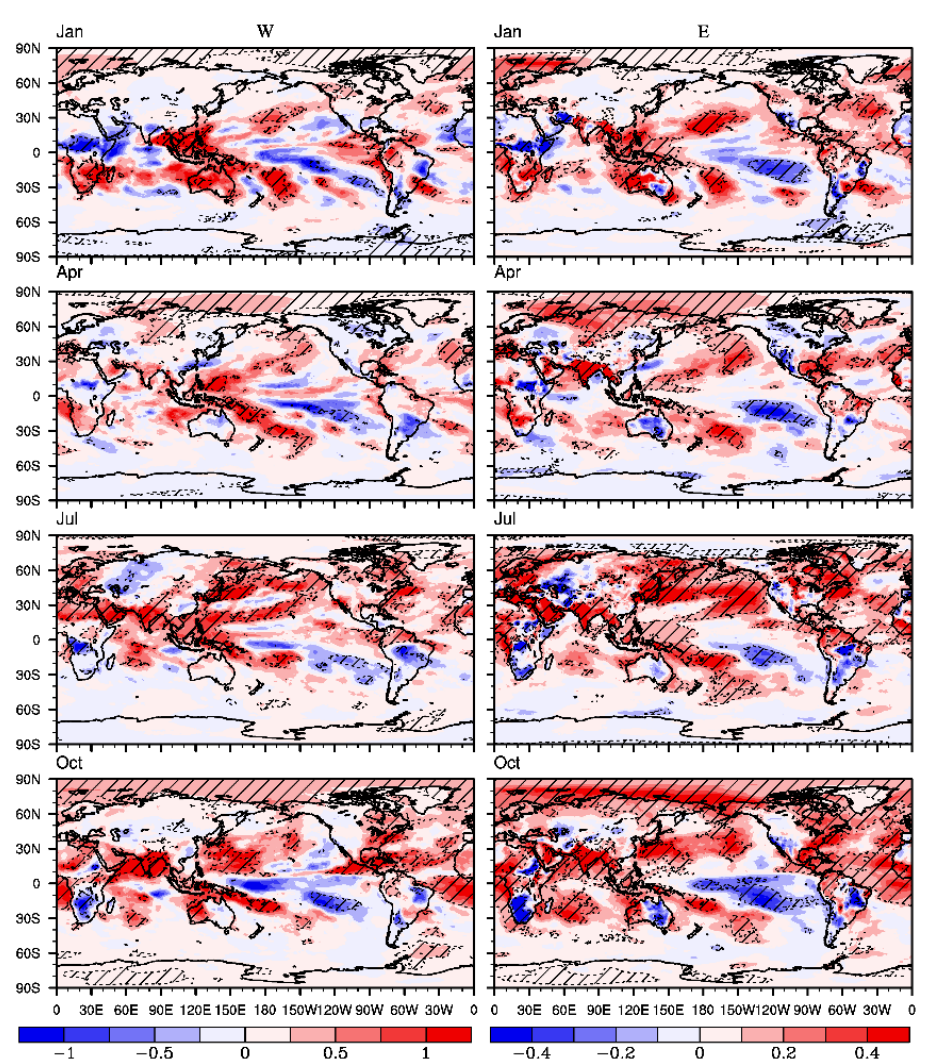
Figure 6. The long-term trends of PW (the left column, unit: kg · m − 2 /10 yr) and SVP (the right column, unit: hPa/10 yr) in four months calculated with the ERA5 dataset. The rows from top to bottom correspond to January, April, July, and October, respectively. Trends in the shaded areas can reach the 0.05 significance